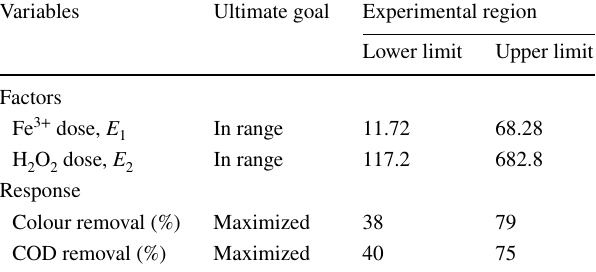
Table 4 The preset goal with the constrains for all the independent factors and responses in numerical optimization